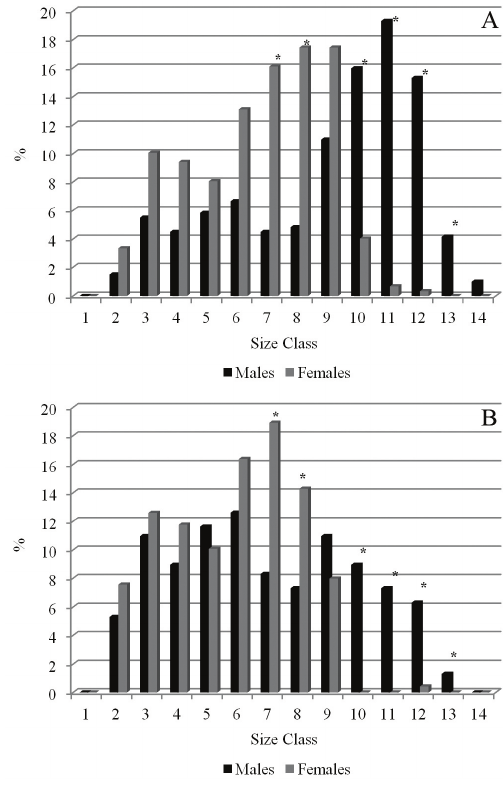
Figure 2. Distribution of the relative frequencies of cephalotoraccic length of males and females, and sex- ratio of the size-classes of Aegla manuinflata . A: All data included. B: Sex-ratio considering only animals caught in the handnet. Markings (*) indicate statistical difference in the sex-ratio (p < 0.05). Size-classes (mm) = 1 = 0 ┤ 2; 2 = 2 ┤ 4; 3 = 4 ┤ 6; 4 = 6 ┤ 8; 5 = 8 ┤ 10; 6 = 10 ┤ 12; 7 = 12 ┤ 14; 8 = 14 ┤ 16; 9 = 16 ┤ 18; 10 = 18 ┤ 20; 11 = 20 ┤ 22; 12 = 22 ┤ 24; 13 = 24 ┤ 26; 14 = 26 ┤ 28.